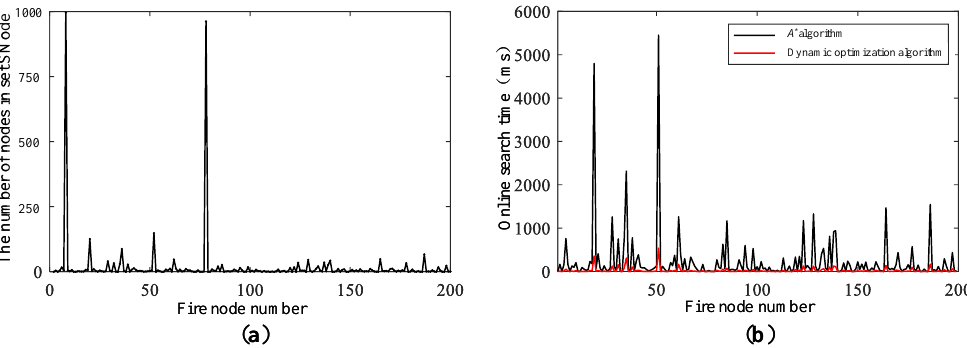
Figure 11. ( a ) Number of nodes in the setwith fire nodes; ( b ) computation time comparison between the algorithm and evacuation route dynamic optimization algorithm for optimized routes.